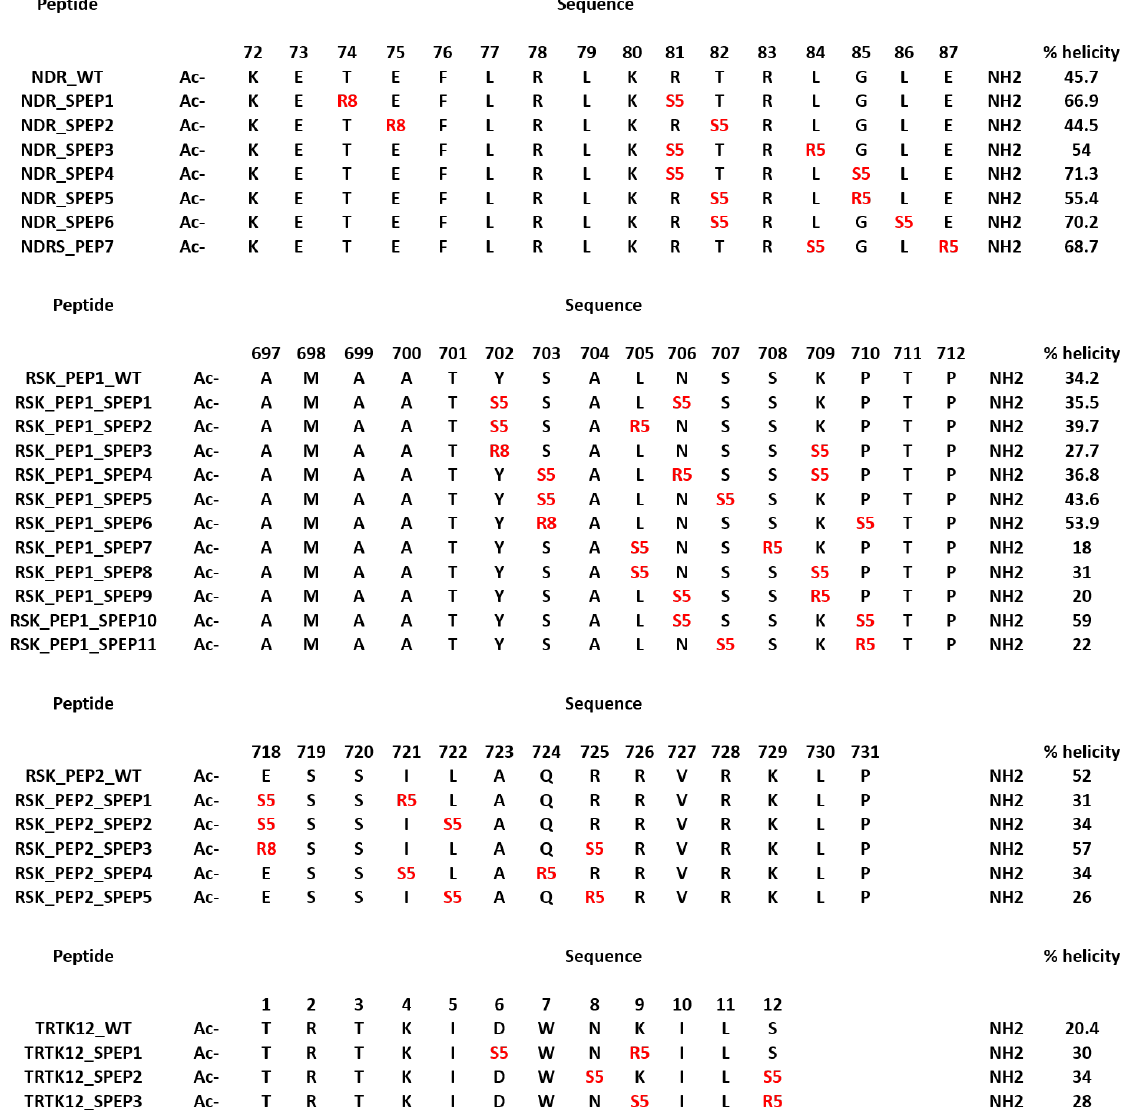
Figure 7. Sequences of the designed stapled peptides. Residues that are linked through all hydrocarbon linkers i,i+3, i,i+4 and i,i+7 are highlighted in red. The helicity (percentage) of peptides when bound to S100B( ββ ) are shown.